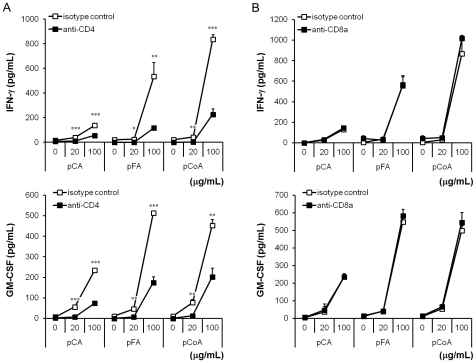
Involvement of CD4 in cytokine production induced by polymerised polyphenols from splenocytes.Splenocytes were pre-incubated with 1 µg/mL of (A) anti-CD4 mAb or (B) anti-CD8a mAb, and each control isotype (rat IgG2b and rat IgG2a; respectively) for 1 h, and then exposed to various polymerised polyphenols (0–100 µg/mL). After 48 h of incubation, the supernatant was collected, and the concentrations of IFN-γ and GM-CSF were determined by ELISA. The values shown represent the mean ± standard deviation, n = 3. Significant difference from isotype control: *p<0.05; **p<0.01; ***p<0.001.